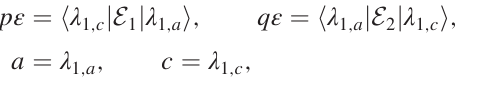
TABLE I. Parameters of the reduced gates, which are used in the figures. In the cases where ε is not stated, we use ε ¼ − 0 . 002660 , − 0 . 014746 , and 0.001 for gates 1, 2, and 3, respectively. We use p ¼ q ¼ 1 [cf. Eq. (81)].